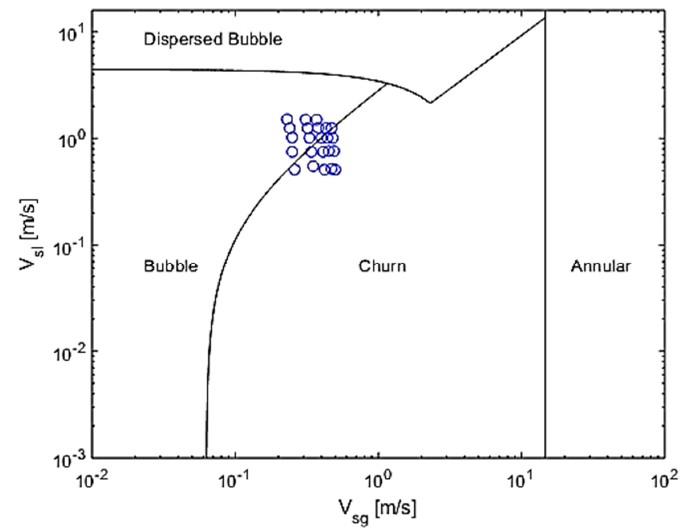
Figure 4. Experimental points and inlet patterns expected upstream of the swirl element, according to [36].